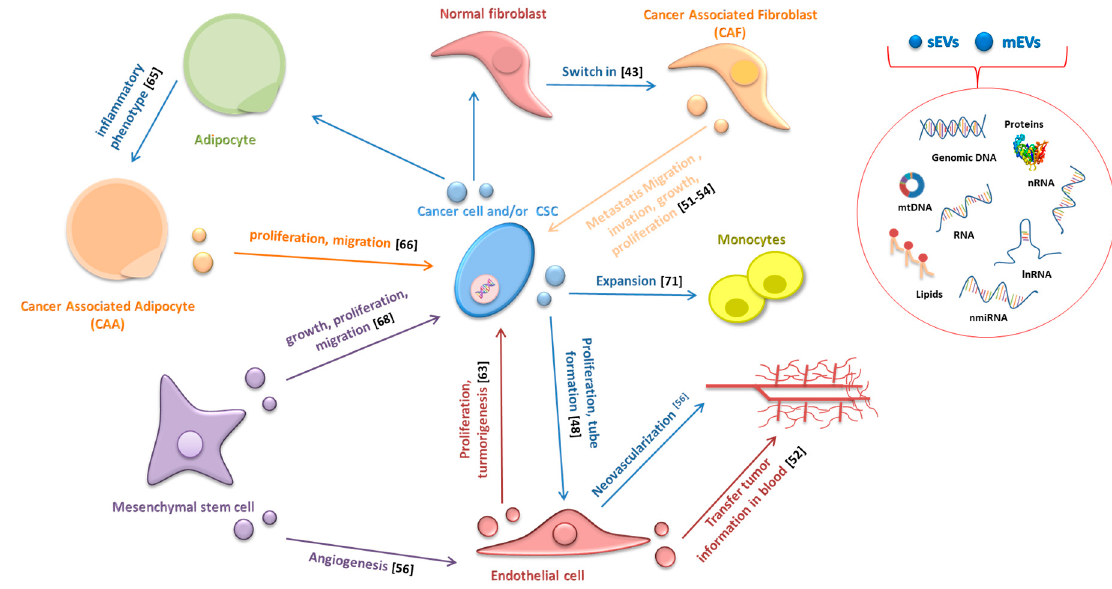
Figure 1. In tumor microenvironments, EVs transport information from cancer cells to other cells and vice versa, and represent an important mechanism of intercellular communication. Table 2. Major microRNAs involved in fibroblasts conversion to CAFs.